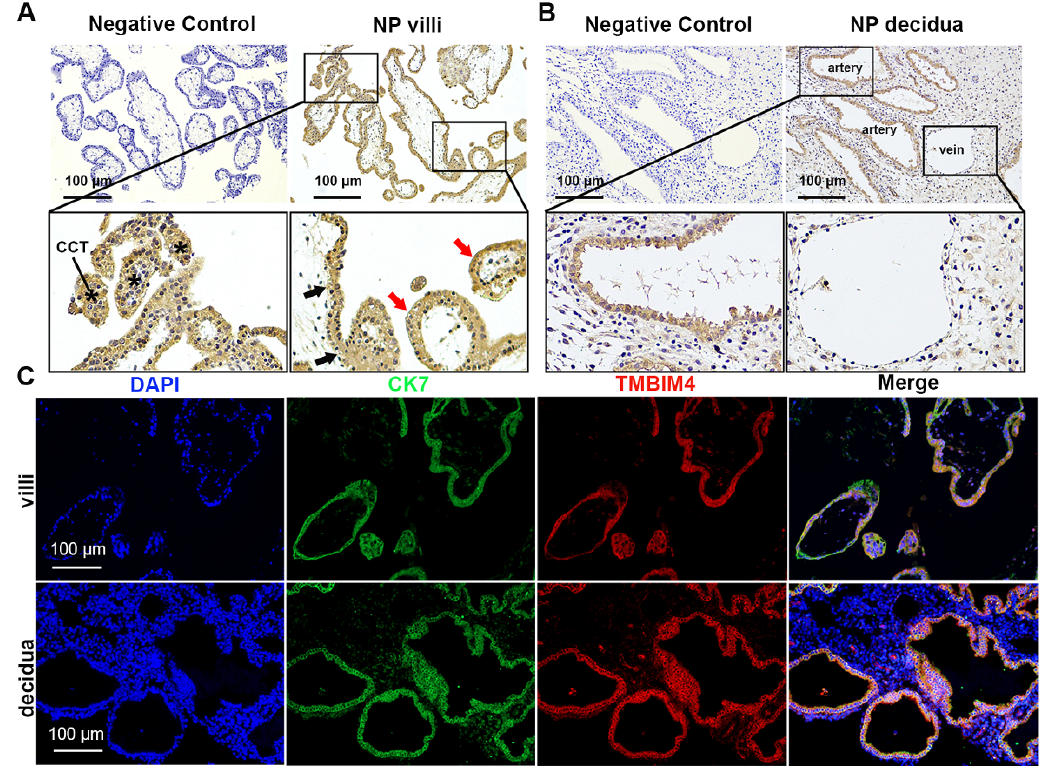
Figure 1. TMBIM4 expression in the trophoblasts of early pregnancy villi and decidua tissue. ( A , B ) Expression of TMBIM4 in early placental villi and decidua. Black arrow: CTB (cytotrophoblasts); red arrow: STB (syncytiotrophoblasts); *: CCT (cell column trophoblast); NP: normal pregnancy. ( C ) Localization of TMBIM4 in the first-trimester villi and decidua was detected via immunofluorescence (red); CK7 was used as the trophoblast marker (green), while DAPI was used to detect the nucleus (blue). Bar = 100 μm.